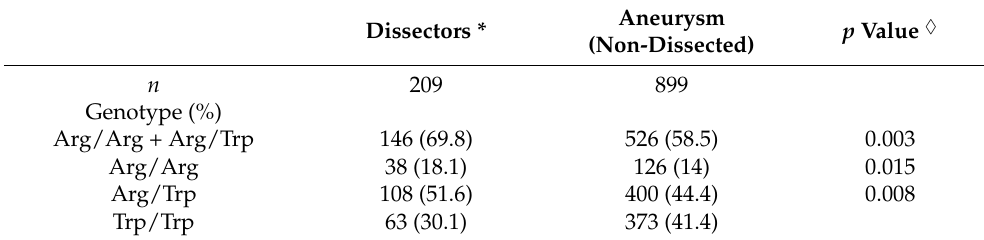
Table 2. KIF6 genotypes, by dissectors vs. non-dissectors.